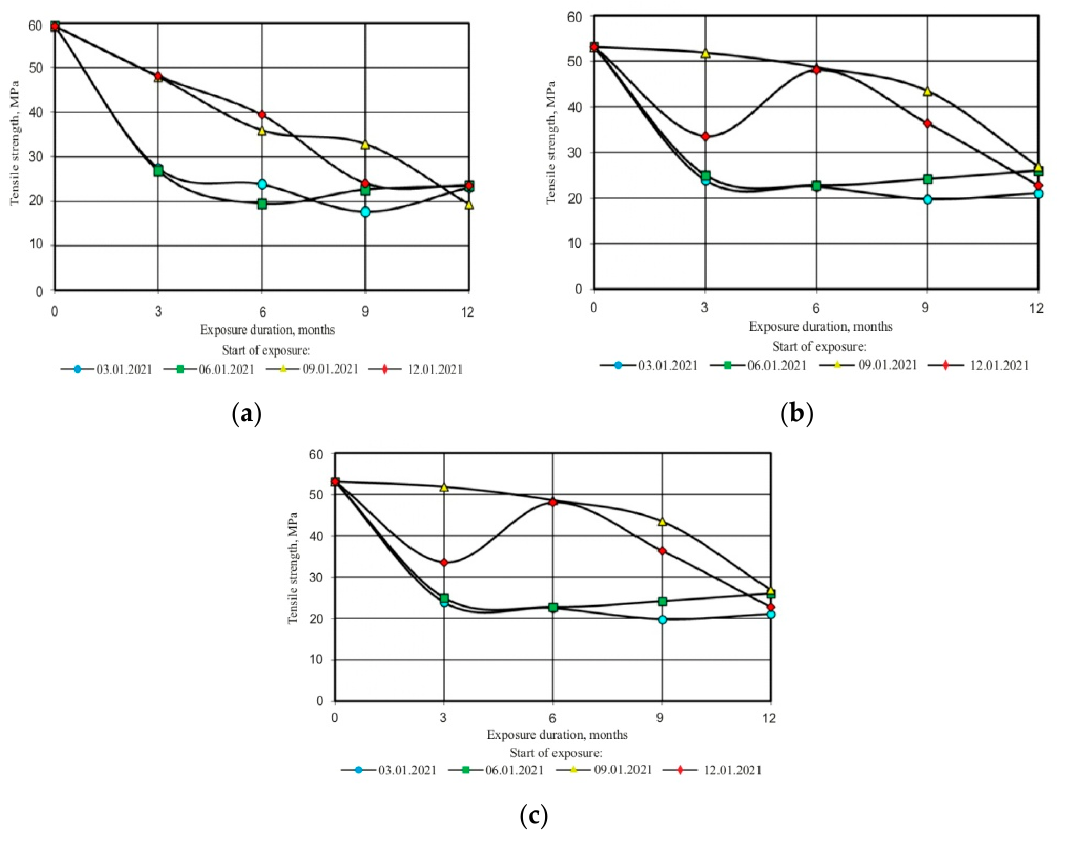
Figure 14. Change in the tensile strength of samples modified by Etal ‐ 1, depending on the season of the start of exposure. ( a ) ED ‐ 20 + Etal ‐ 45M, ( b ) 90% ED ‐ 20 + 10% Etal ‐ 1 + Etal ‐ 45M and ( c ) Etal ‐ 247 + Etal ‐ 45M.